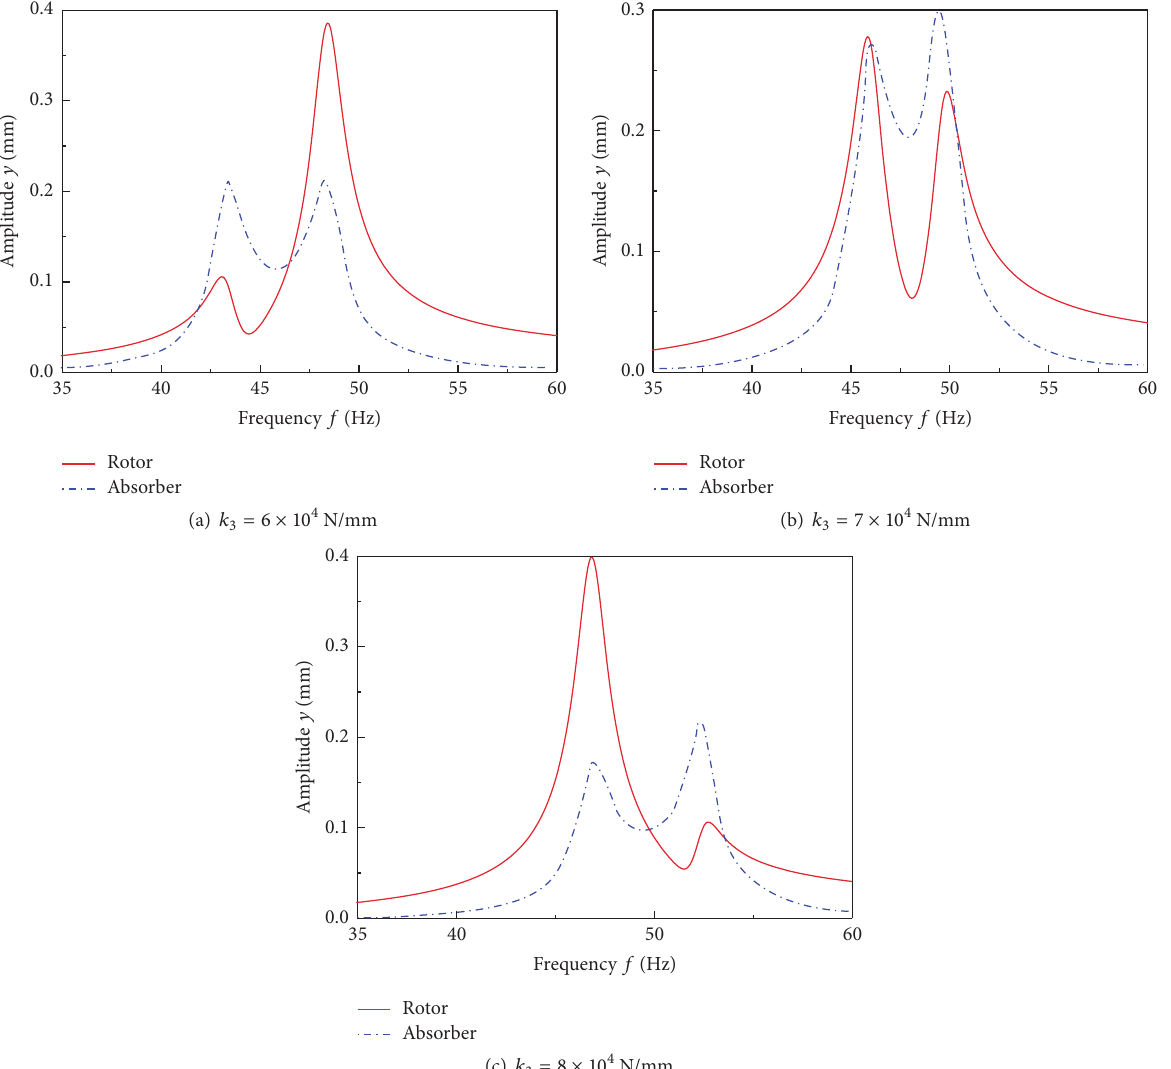
Figure 8: Responses of the rotor-absorber system when ℎ is